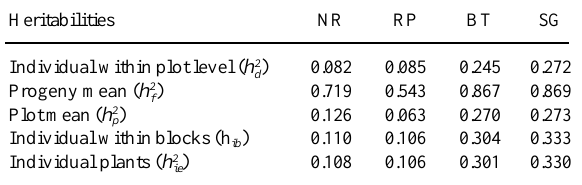
Table II - Heritability coefficients for total number of vessel rings (NR), rubber production (RP), bark thickness (BT) and stem girth (SG) for different comparisons in three-year-old progenies of Hevea brasiliensis.